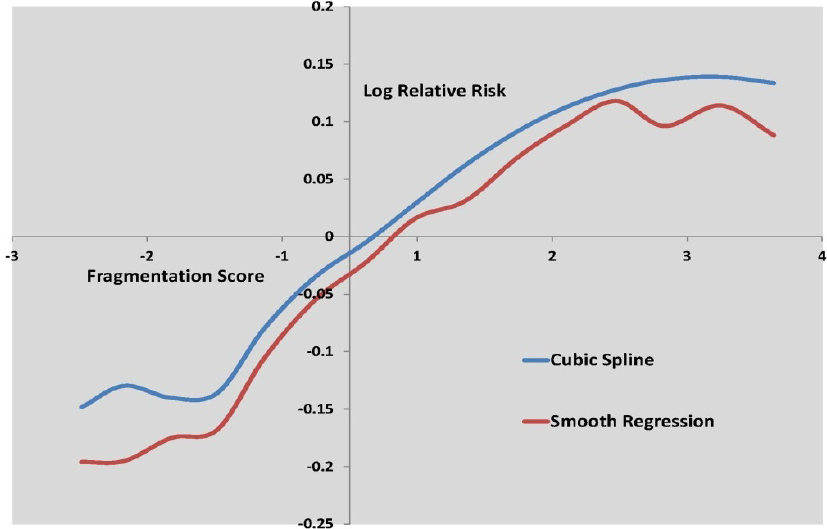
Figure 4. Log relative risk by fragmentation score, cubic spline and smooth